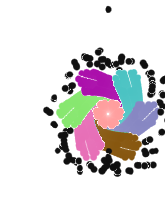
Figure 6. Ionic adsorption capacity of a nanorope.